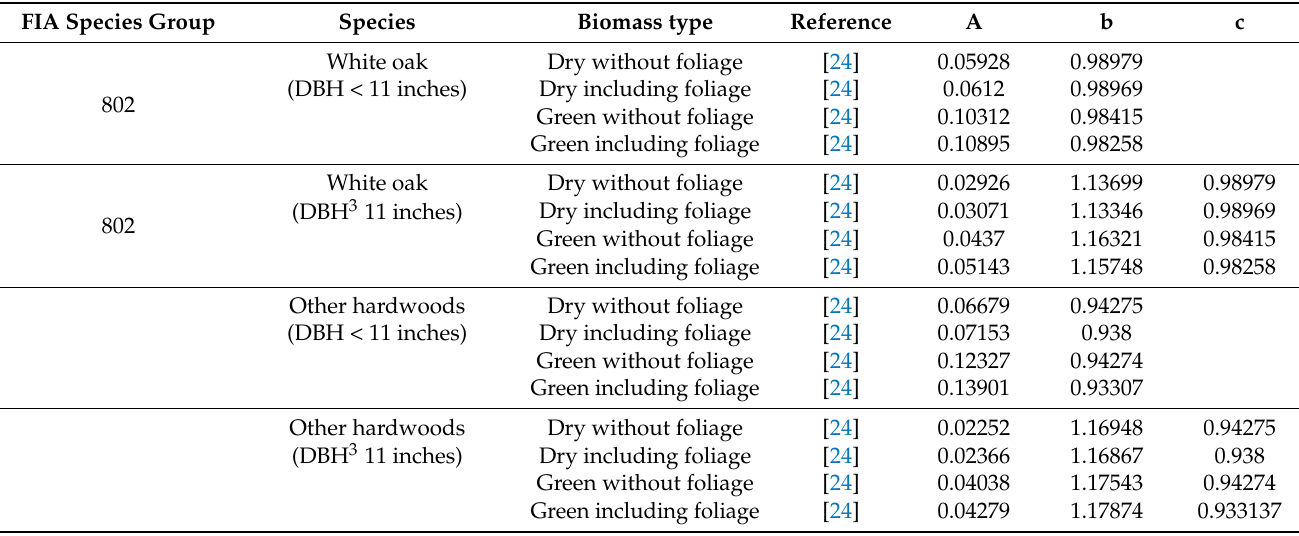
Table A3. Sources of the original equations and parameters of the biomass Equations (3) and (4) for hardwood